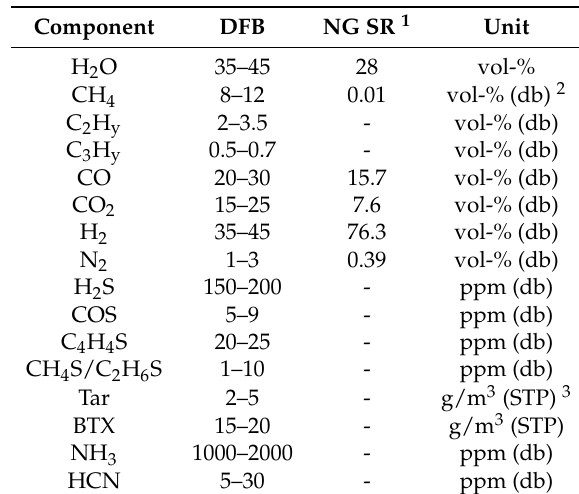
Table 1. Typical values for product gas composition after DFB gasification in comparison to gas composition after natural gas steam reforming